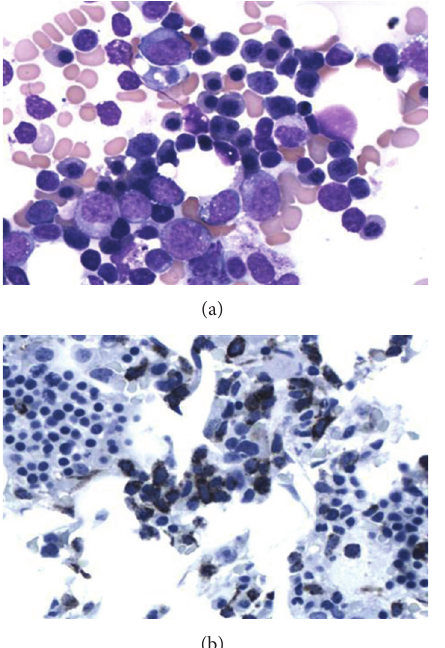
Figure 1: (a) Bone marrow aspirate on diagnosis showing myeloid hyperplasia with blasts. (b) Bone marrow aspirate at diagnosis with CD34 stain.